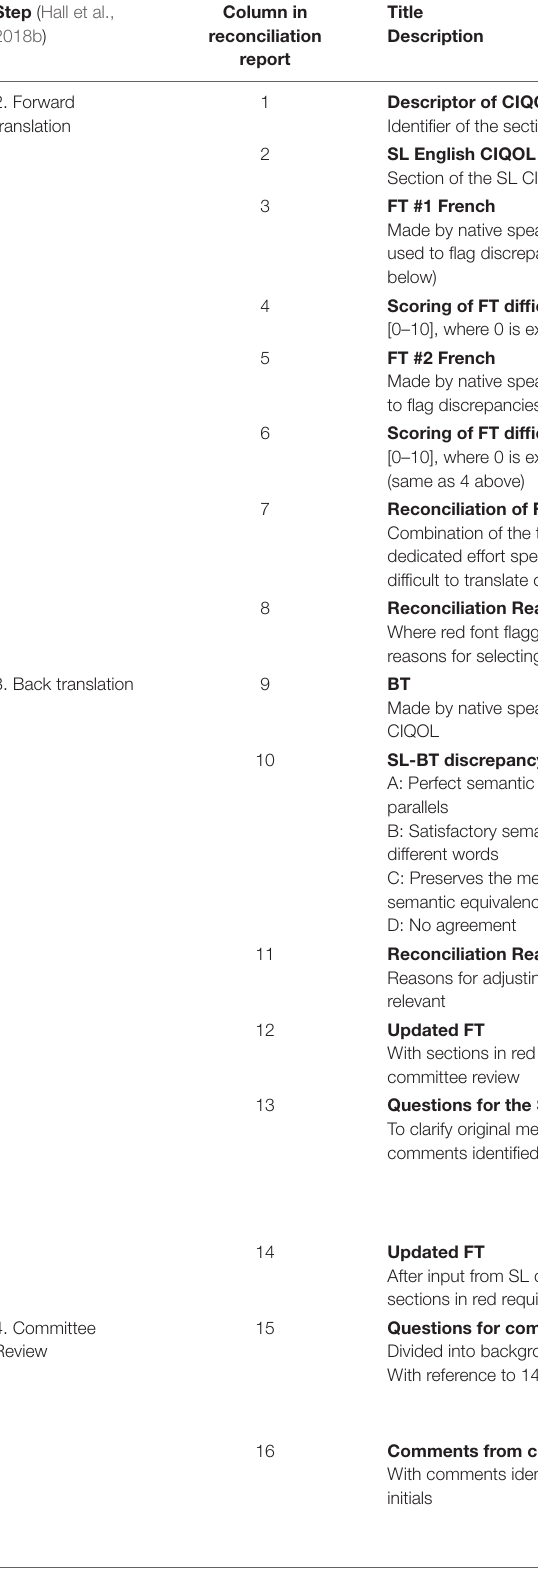
TABLE 3 | Reconciliation report and how it was adapted from Hall et al. (2018b) supplemental file 3 for the purposes of the present translation project. Step (Hall et al.,